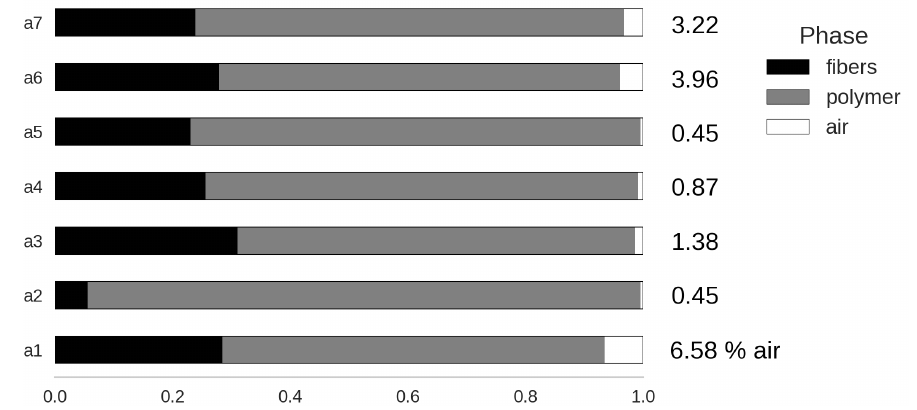
Figure 5. Relative phase volume fractions determined from segmented tomograms of specimens a1 to